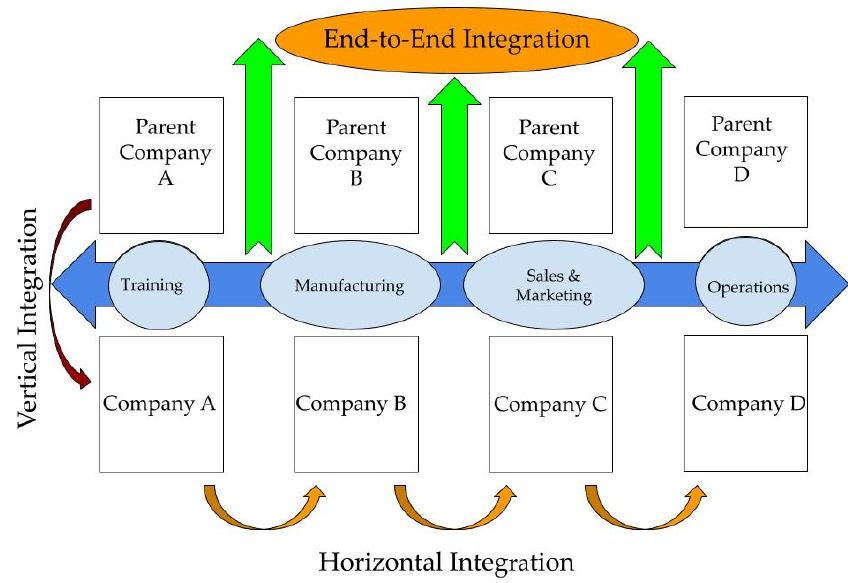
Figure 7. Sketch of the three integration types and their association.